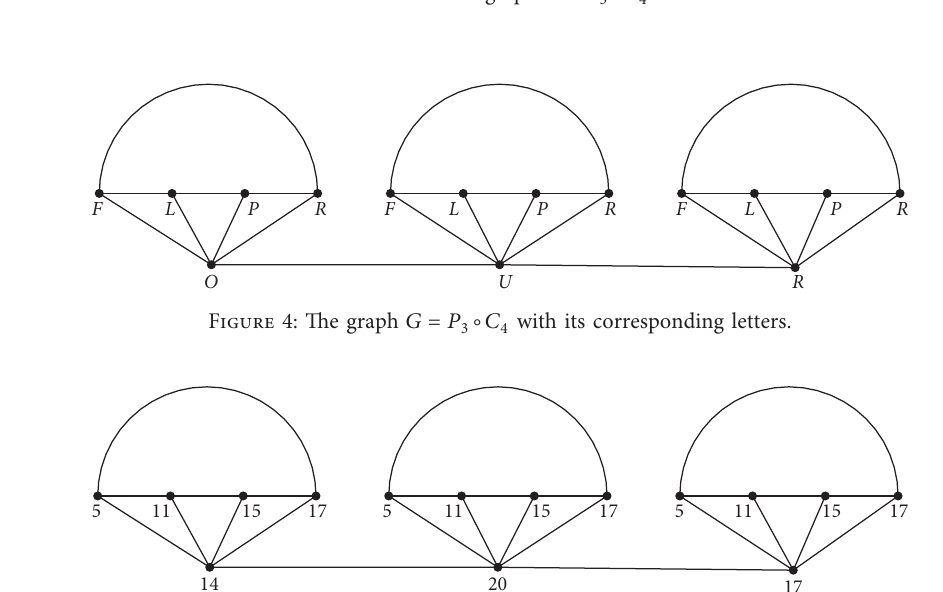
Figure 3: The graph G � P